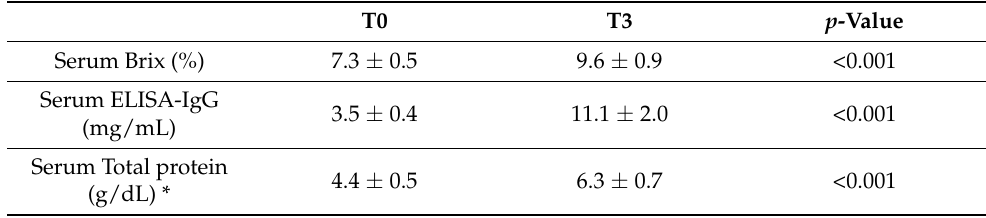
Table 3. Differences (Mean ± standard deviation) between calf serum Brix measurements (%, g/dL) and ELISA results (mg/mL) at T0 (at birth) and at T3 (72 hours after